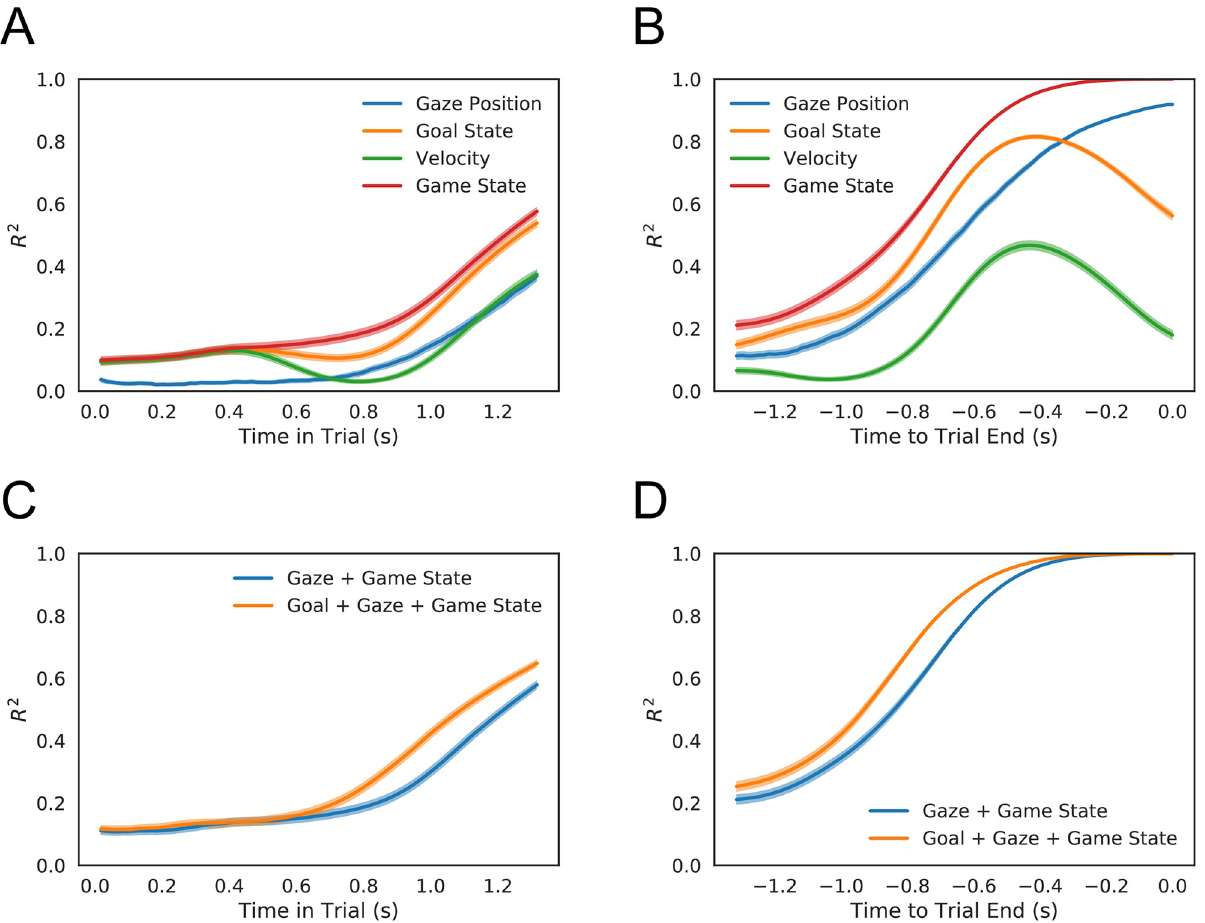
Fig 5. Inferred goals predict game endpoints. A, B: Predictive power (as measured by R 2 ) for a model predicting final puck position as a function of either shooter gaze position, instantaneous velocity, game state, or inferred goal. C, D: Predictive power for a model predicting final puck position as a function of all variables with or without inferred goals. A, C: Aligned to trial start. B, D: Aligned to trial end. Game states consistently outperform the other variables. Inferred goals are just as predictive as the velocity of movement for the first 0.4s, but become more predictive thereafter. They remain more predictive than either measure until 0.3s before trial end, when gaze becomes a better predictor. In general, including inferred goal states in the model enhances the predictive power.